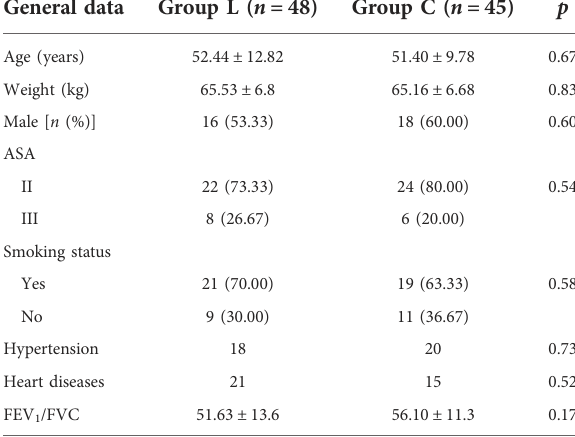
TABLE 1 Patient general information